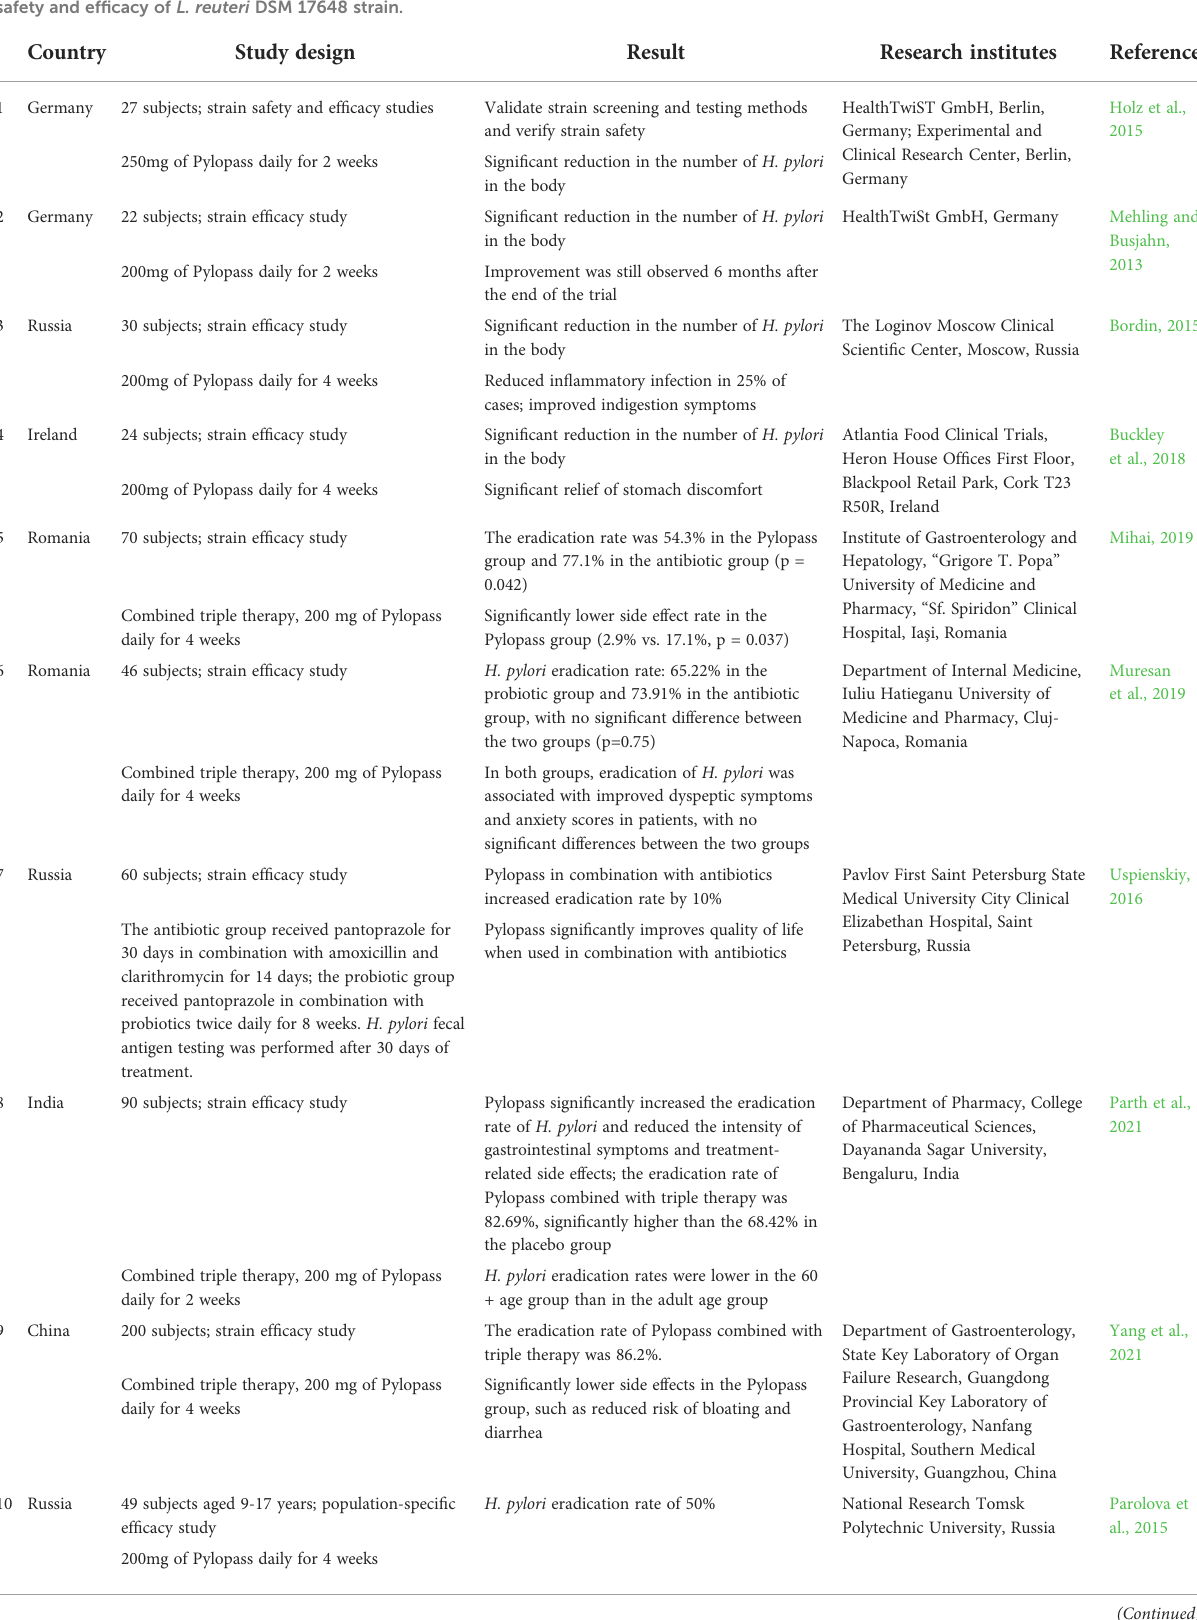
TABLE 4 Completed and ongoing clinical trials with 951 subjects in 6 countries: Germany, Ireland, Russia, Romania, China, and India on the safety and ef fi cacy of L. reuteri DSM 17648 strain.